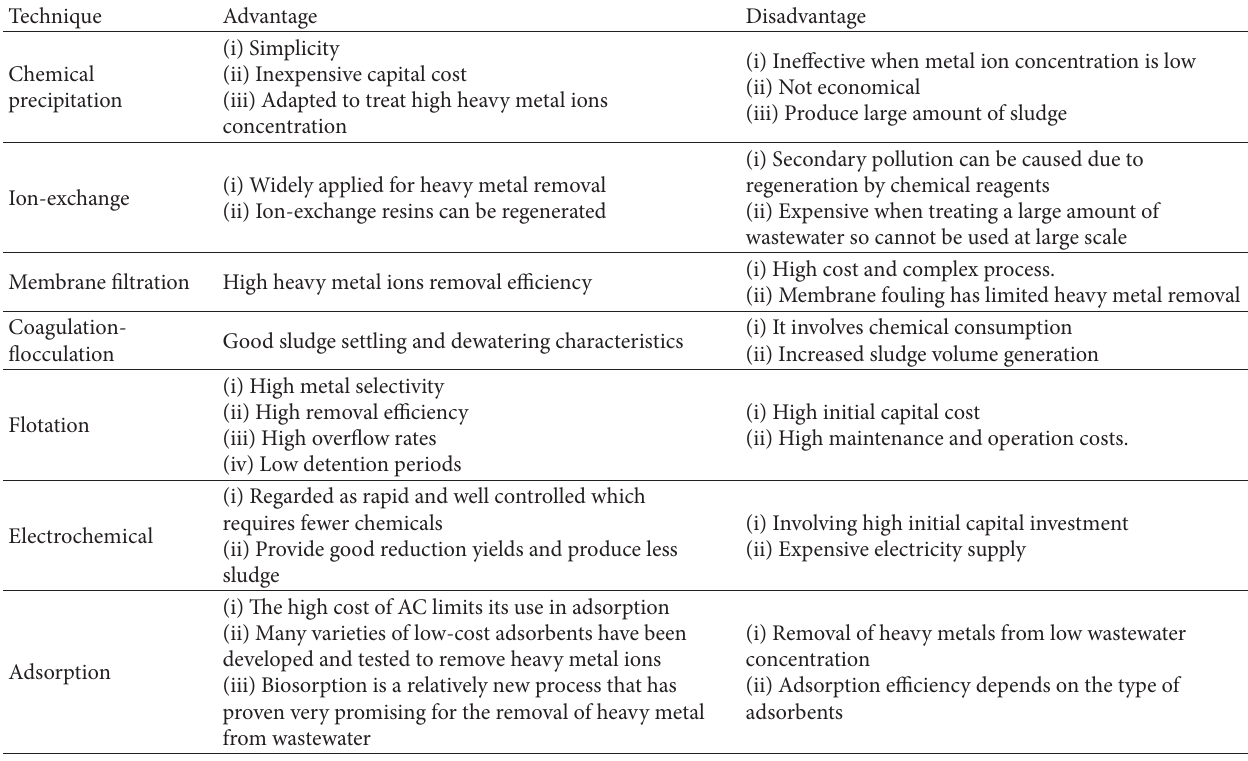
Table 2: Comparison among wastewater treatment